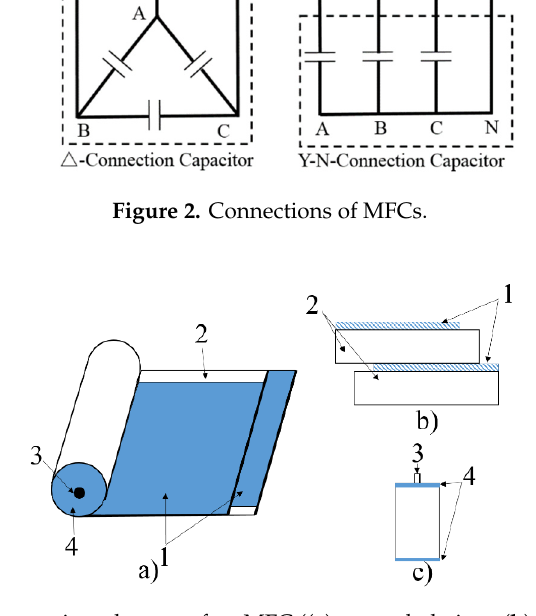
Figure 2. Connections of MFCs.